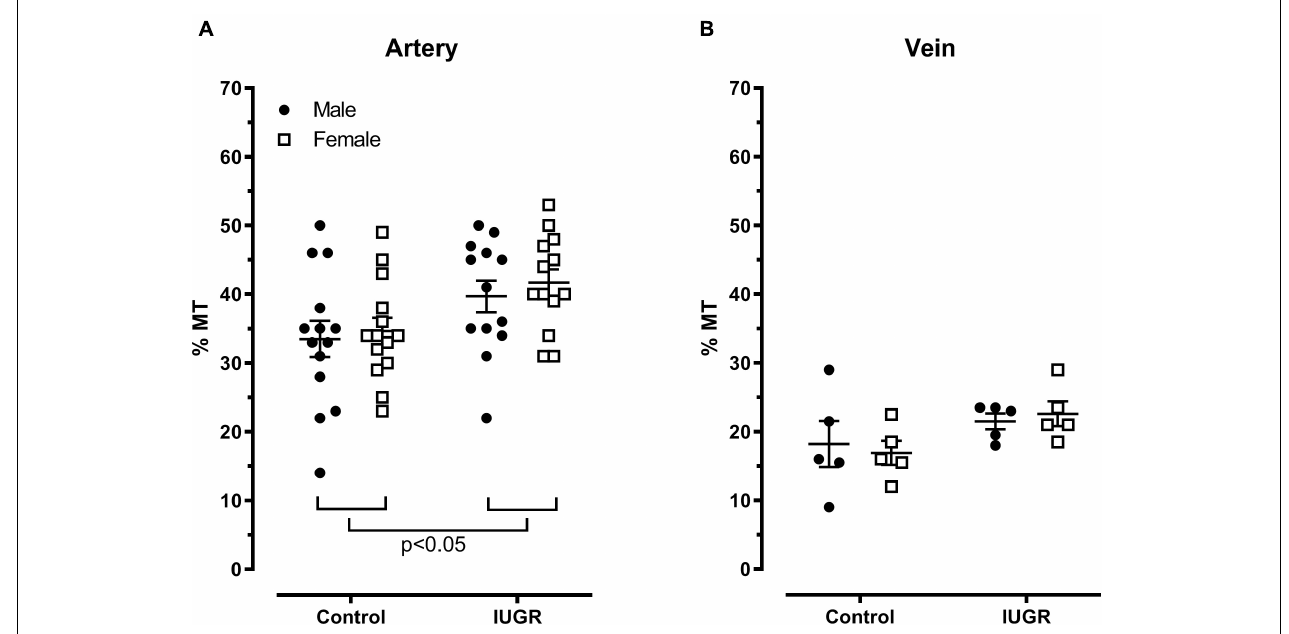
FIGURE 7 | Percent myogenic tone (%MT) in the umbilical artery (A) and vein (B) . Control ( n = 14), IUGR ( n = 13). Lines represents mean ±